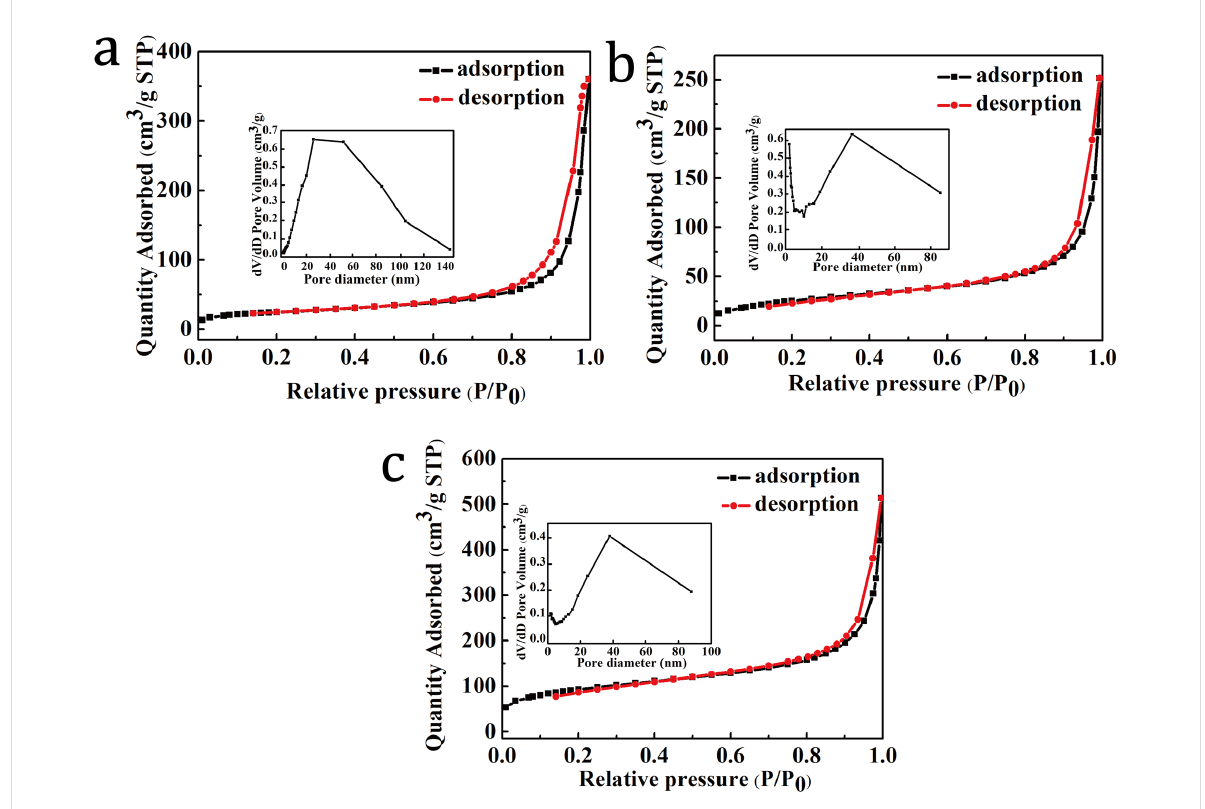
Figure 5: Nitrogen adsorption/desorption isotherms and pore size distribution curves of (a) CA, (b) NiMoO 4 /CA (b), and (c) NiMoO 4 @Co 3 O 4 /CA com- posite.